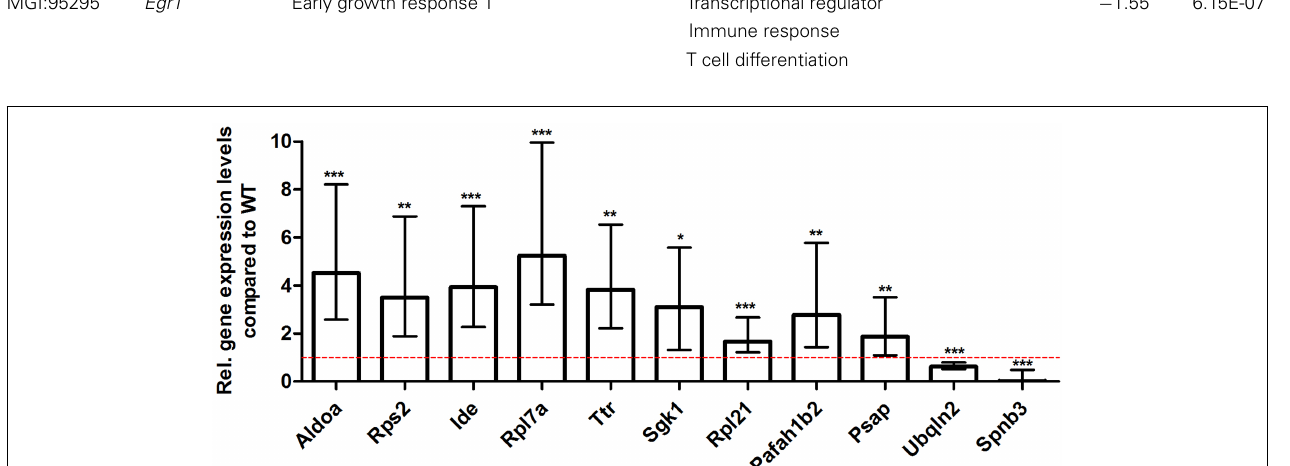
FIGURE 7 |Validation of young 5XFAD deep sequencing results through quantitative real-time polymerase chain reaction (qRT-PCR) analysis .To confirm the deep sequencing data, qRT-PCR experiments for various genes were performed on young 5XFAD and age-matchedWT mice. Expression